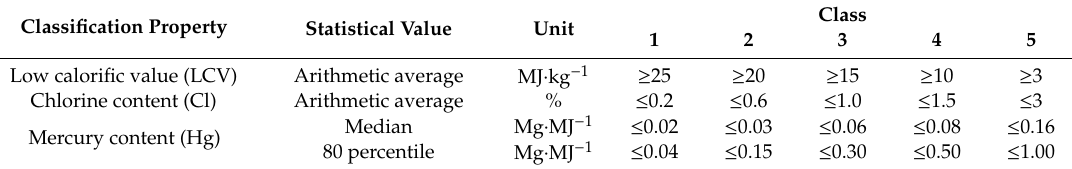
Table 1. Quality requirements for particular classes of fuels formed from waste